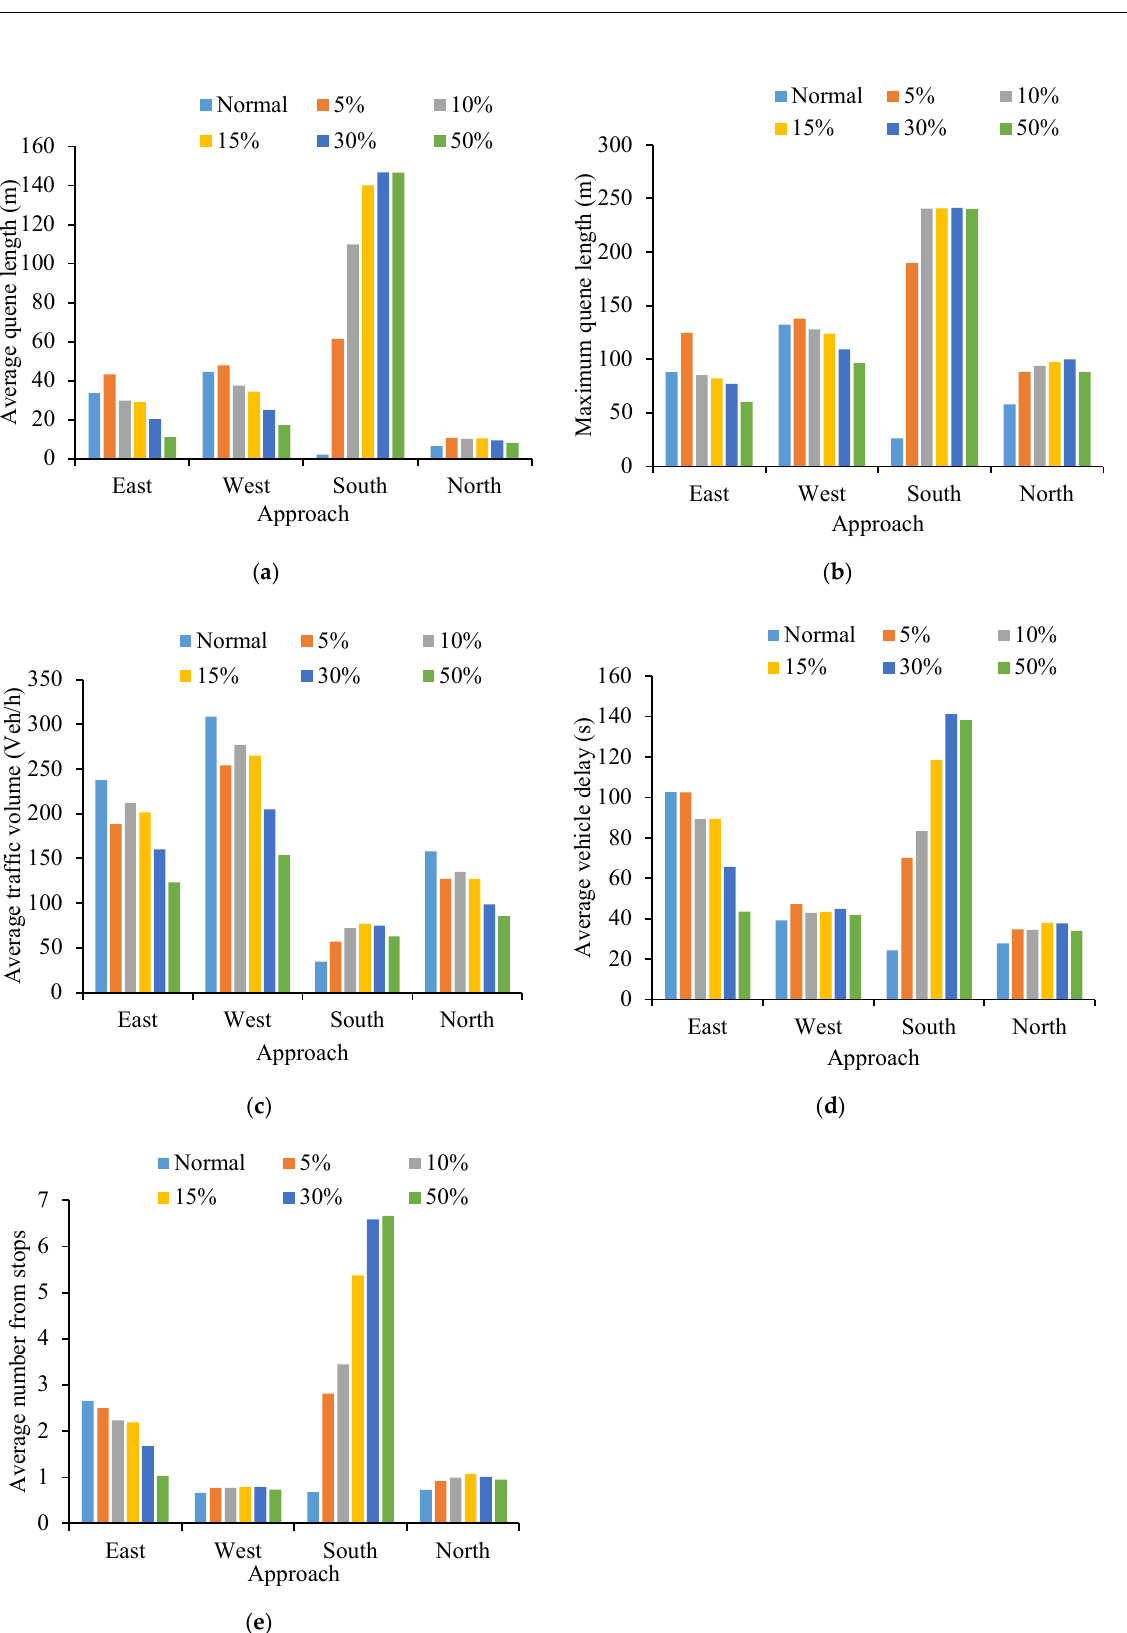
Figure 12. Comparison of five MOEs at different approaches of no. 3 intersection. ( a ) Average queue length at different approaches of no. 3 intersection. ( b ) Maximum queue length at different approaches of no. 3 intersection. ( c ) Average traffic volume at different approaches of no. 3 intersection. ( d ) Average vechicle delay at different approaches of no. 3 intersection. ( e ) Average number from stops at different approaches of no. 3 intersection.